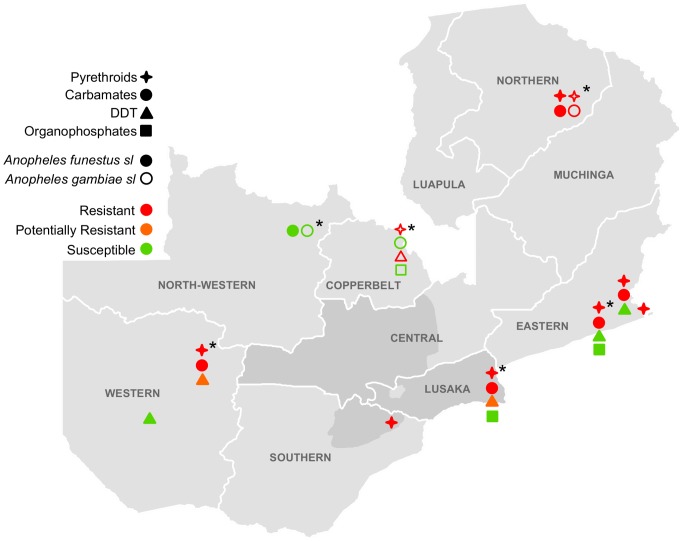
Insecticide resistance in collections from March 2011–April 2012.Darker gray shading indicates areas surveyed in [16]. *locations with microarray data.